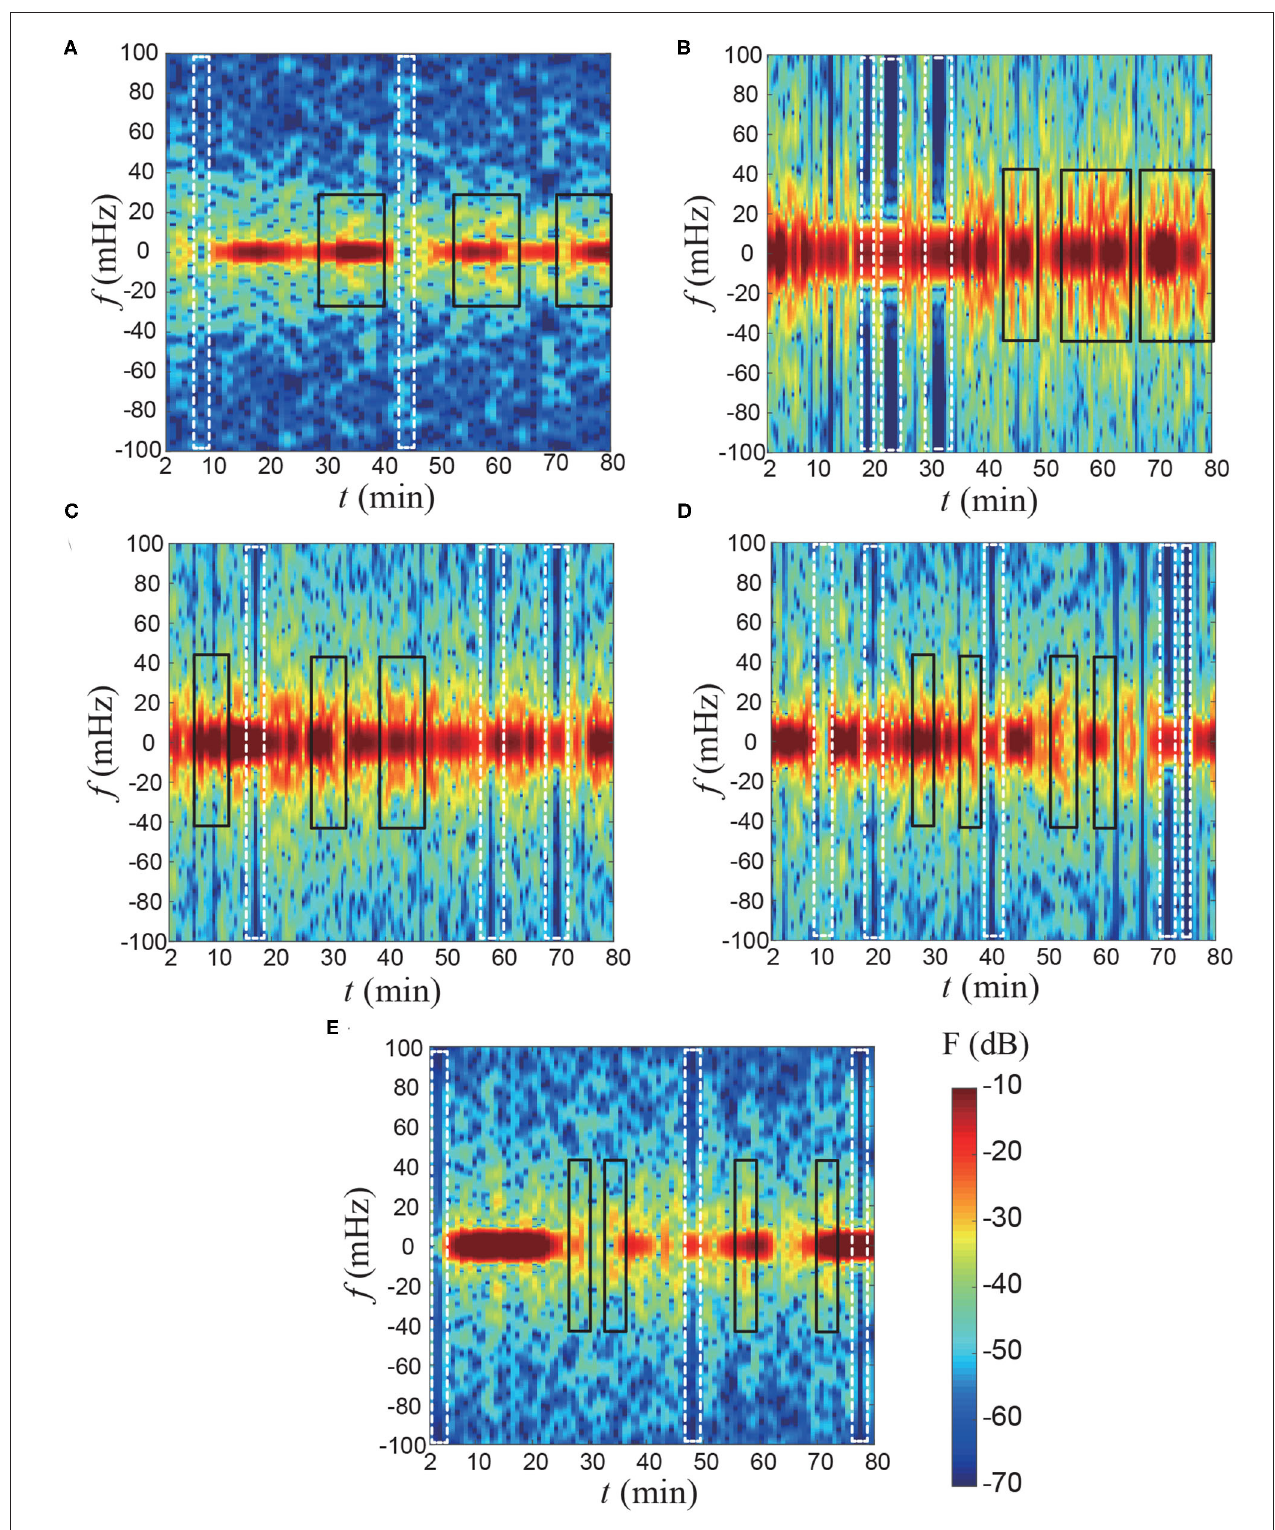
FIGURE 5 | Temporal power spectrum results of the flux of floral scents. The results are reconstructed based on Figure 4B using a moving average filter for every 5 min. (A) Sample 1, (B) Sample 2, (C) Sample 3, (D) Sample 4, and (E) Sample 5. The contours represent a magnitude (F) of the power spectrum. The white dashed-box indicates that the fragrance is temporally stopped emitting. The black rectangular box highlights the similar temporal power spectrum signal for each flower.